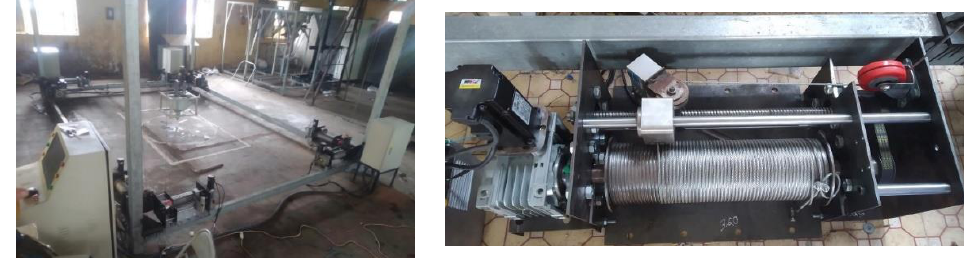
Figure 19. Cable robot and Winch.